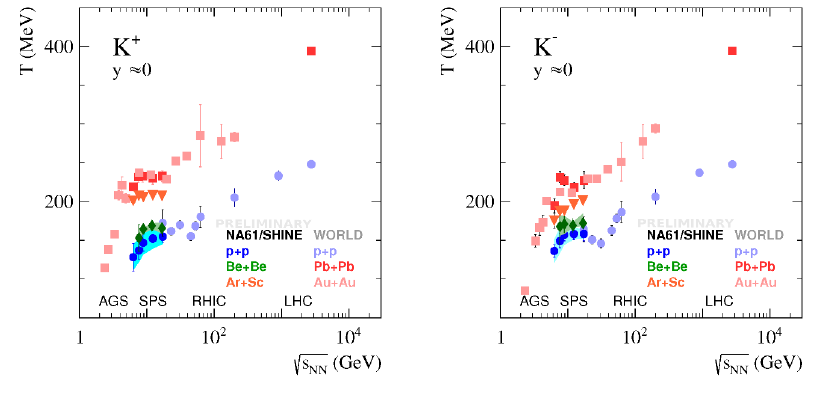
Figure 2. Inverse slope parameter T of K + ( left ) and K − ( right ) m T spectra as a function of collision energy for p + p, Be + Be, Ar + Sc and Pb + Pb / Au + Au